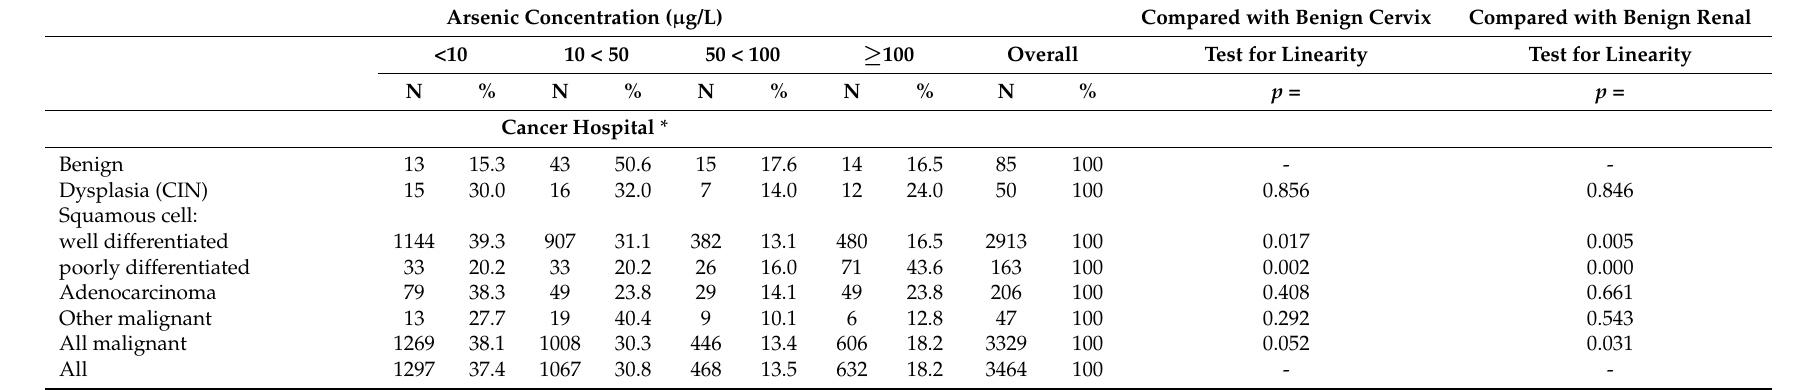
Table 2. Arsenic concentration by